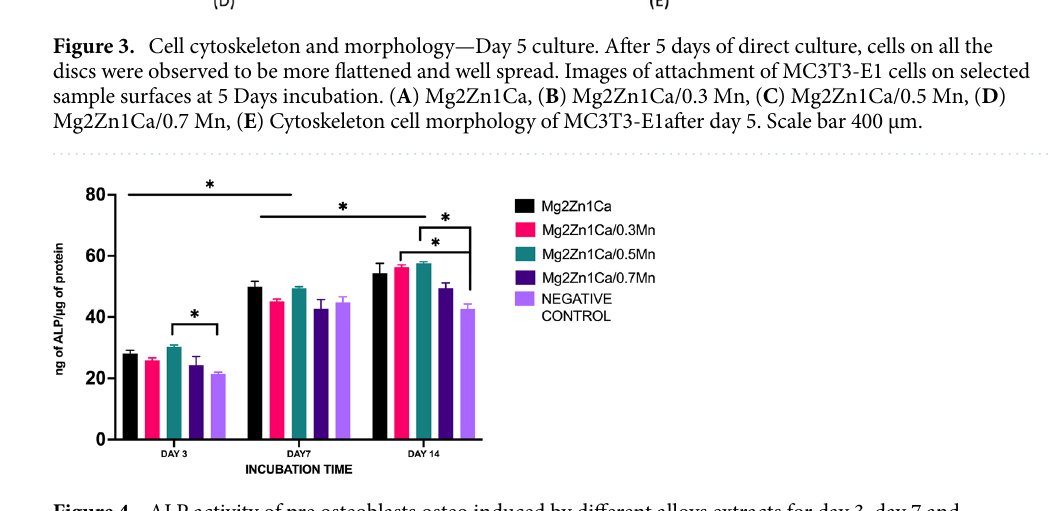
Figure 4. ALP activity of pre osteoblasts osteo induced by different alloys extracts for day 3, day 7 and day 14 culture. Osteogenic medium induced cells culture was used as negative control. The ALP activity of the manganese containing alloy groups shows increased ALP activity compared to Mg2Zn1Ca alloy and the negative control (Osteogenic media with cells). Error bars indicate mean ± standard deviation ( n = 3, independent samples) (* P <